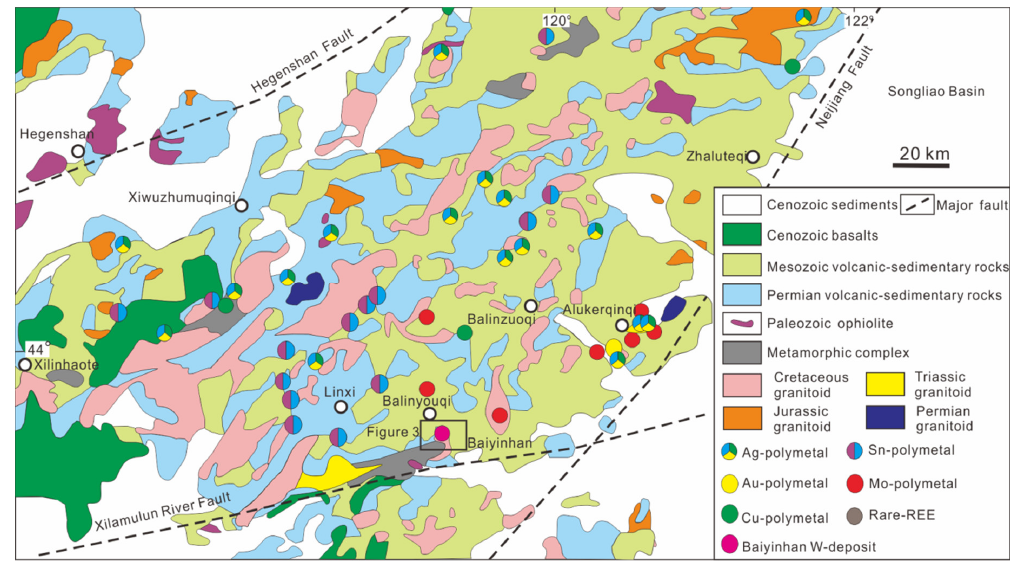
Figure 2. Regional geological map of south DaHinggan mountains showing the distribution of the metal ore deposits (modified from [34,35]).